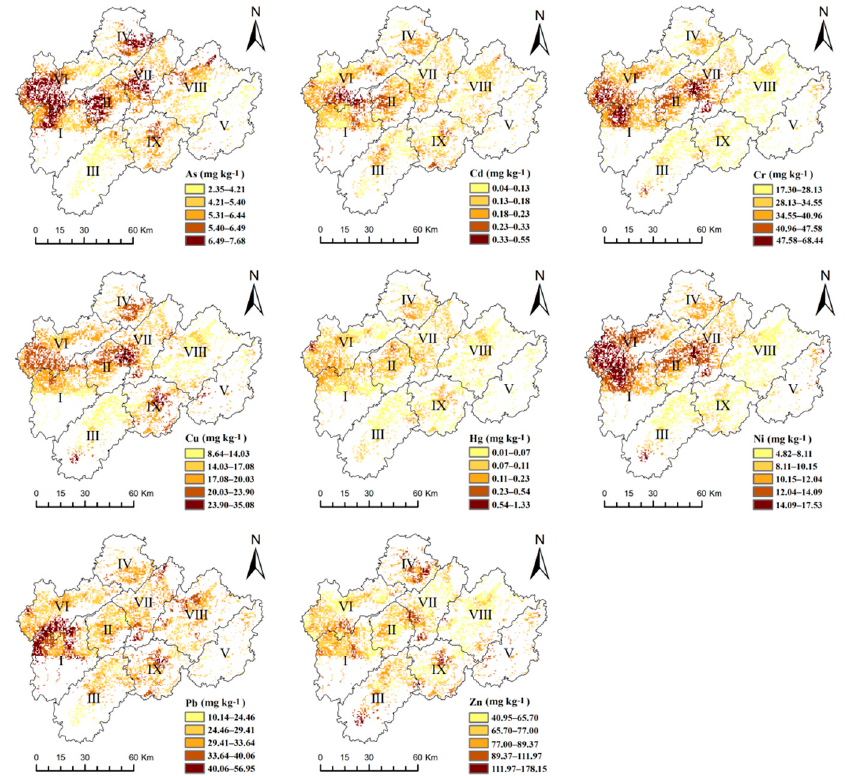
Figure 2. Spatial distribution of soil heavy metal concentrations of farmland area in Jinhua City. I: Wucheng District; II: Jindong District; III: Wuyi County; IV: Pujiang County; V: Pan’an County; VI: Lanxi City; VII: Yiwu City; VIII: Dongyang City; IX: Yongkang